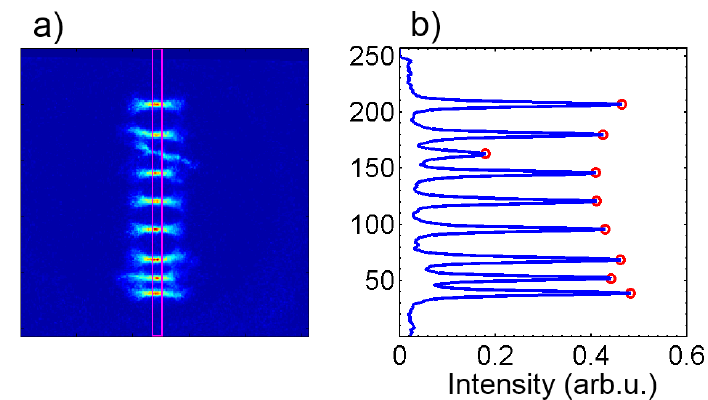
Figure 6 : Example of iCCD image processing: a) DCSBD discharge pattern in false colours with marked area of interest (electrode gap); b) Corresponding intensity profile with identified filaments marked with circles, on y-axis the row pixel number is